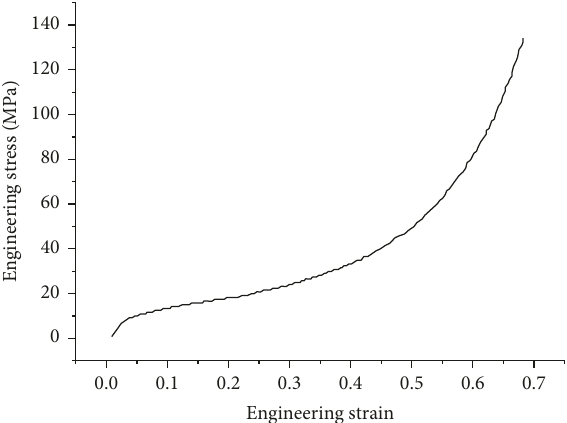
Figure 12: Stress-strain curve of industrial pure aluminum foam.